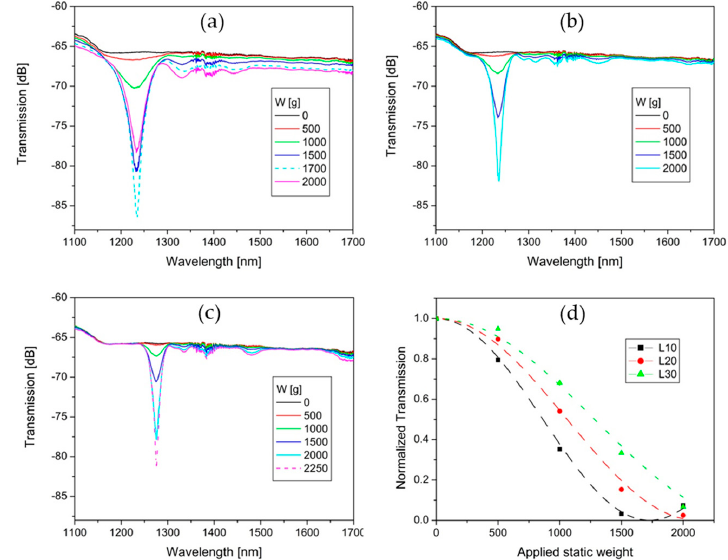
Figure 5. Spectrum transmission evolution for ( a ) L10, ( b ) L20, and ( c ) L30 under the increase of applied static weight. ( d ) Attenuation depth of the leading rejection bands versus applied static weight.